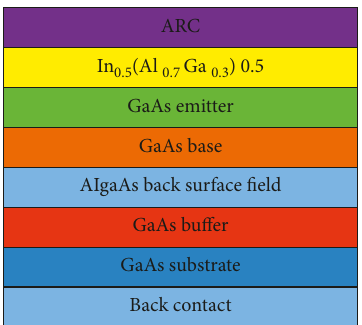
Figure 7: Schematic structure of GaA-based PV